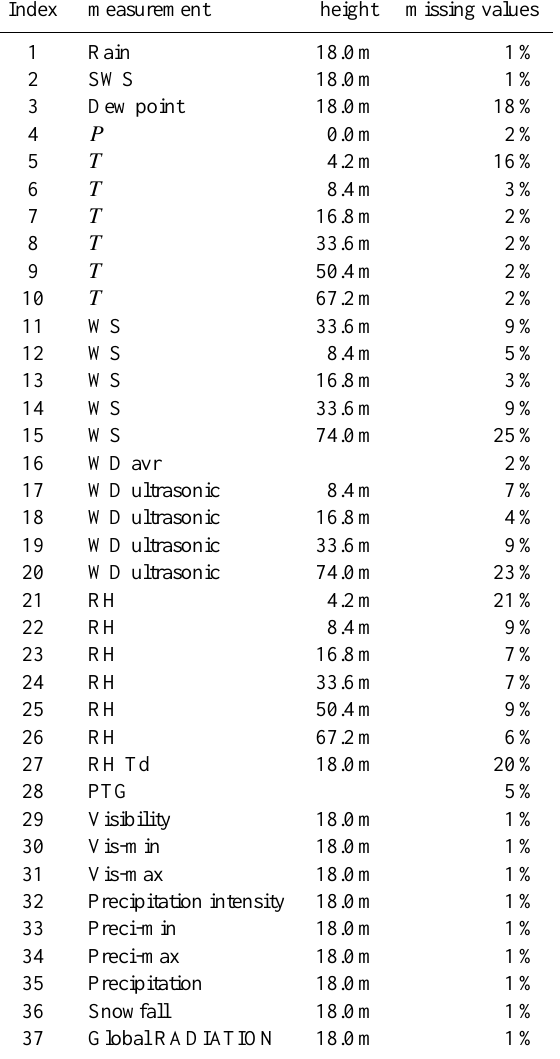
Table 1. Sensors for the case study: SWS - surface wetness sensor, P - pressure, T - temperature, WS - wind speed, WD - wind direction, RH - relative humidity, RH Td -relative humidity calculated using dew point, PTG - potential temperature gradient, Vis - visibility.